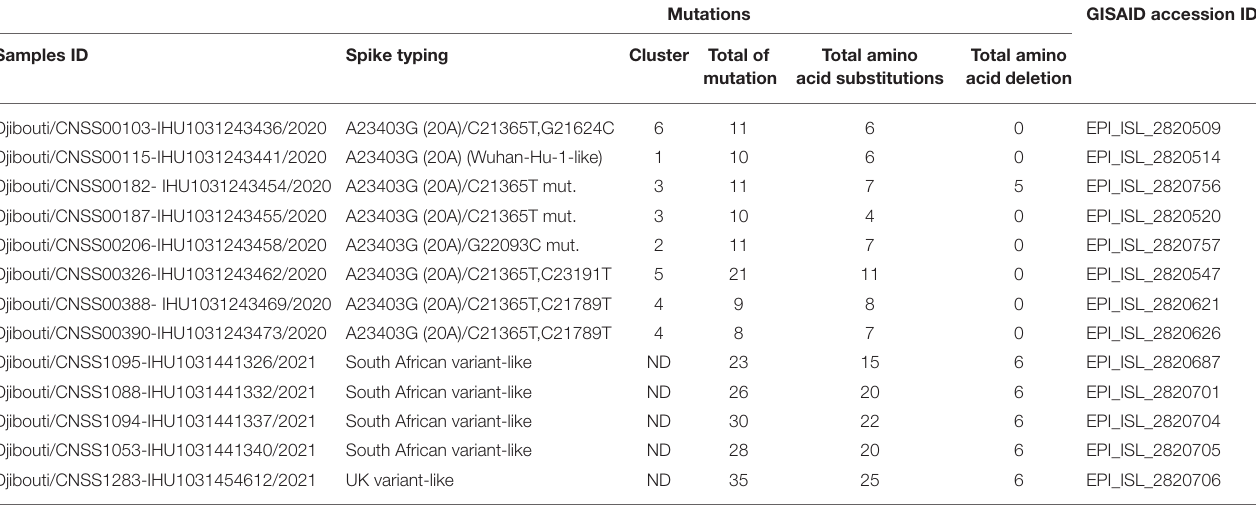
TABLE 2 | Genotyping of SARS-CoV-2 strains circulating in Djibouti from May 2020 to March